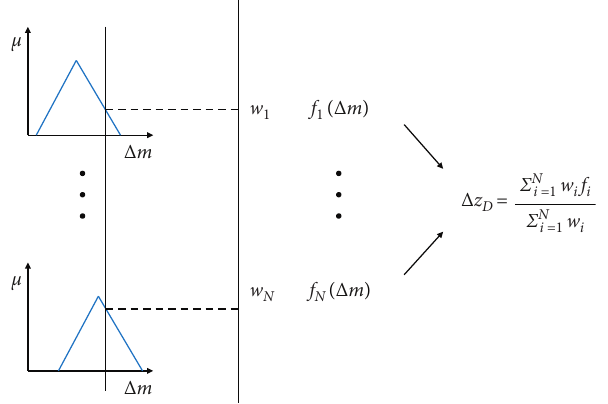
Figure 6: Sugeno fuzzy logic inference